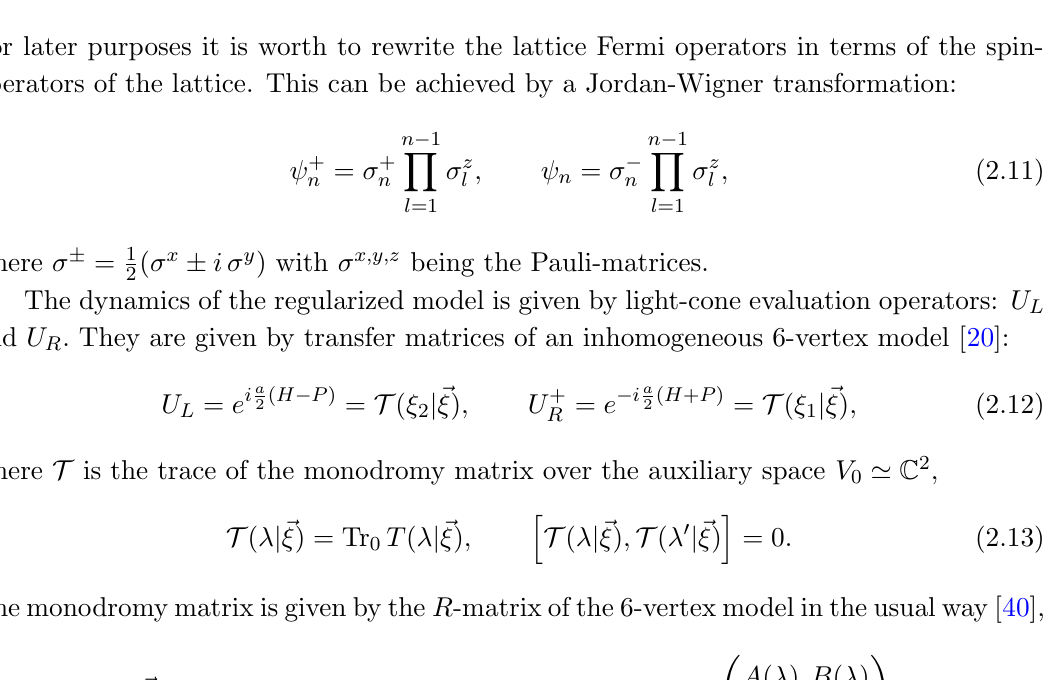
Figure 1 . The pictorial representation of the light-cone